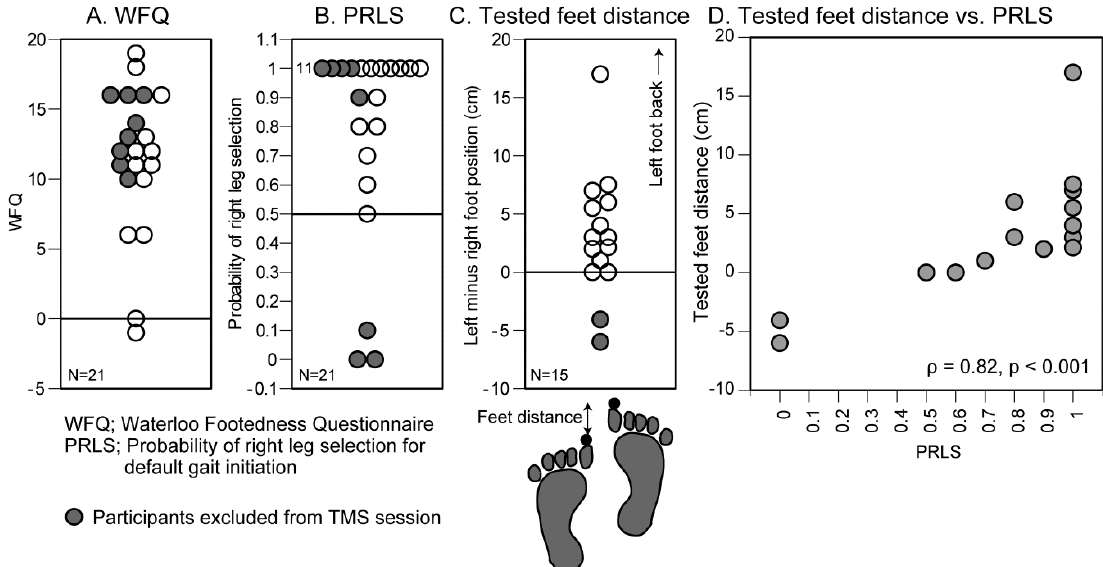
Figure 1. Waterloo Footedness Questionnaire (WFQ) ( A ), probability of right leg selection (PRLS) of the default gait initiation ( B ), the tested feet distance ( C ), and the plots of the tested feet distance as relation with the PRLS ( D ). Each data point indicates one participant. Filled circles indicate the participants excluded from the TMS session. The number in panel B indicates the number of participants who initiated the gait with the right leg across all trials ( B ). TMS: transcranial magnetic stimulation.